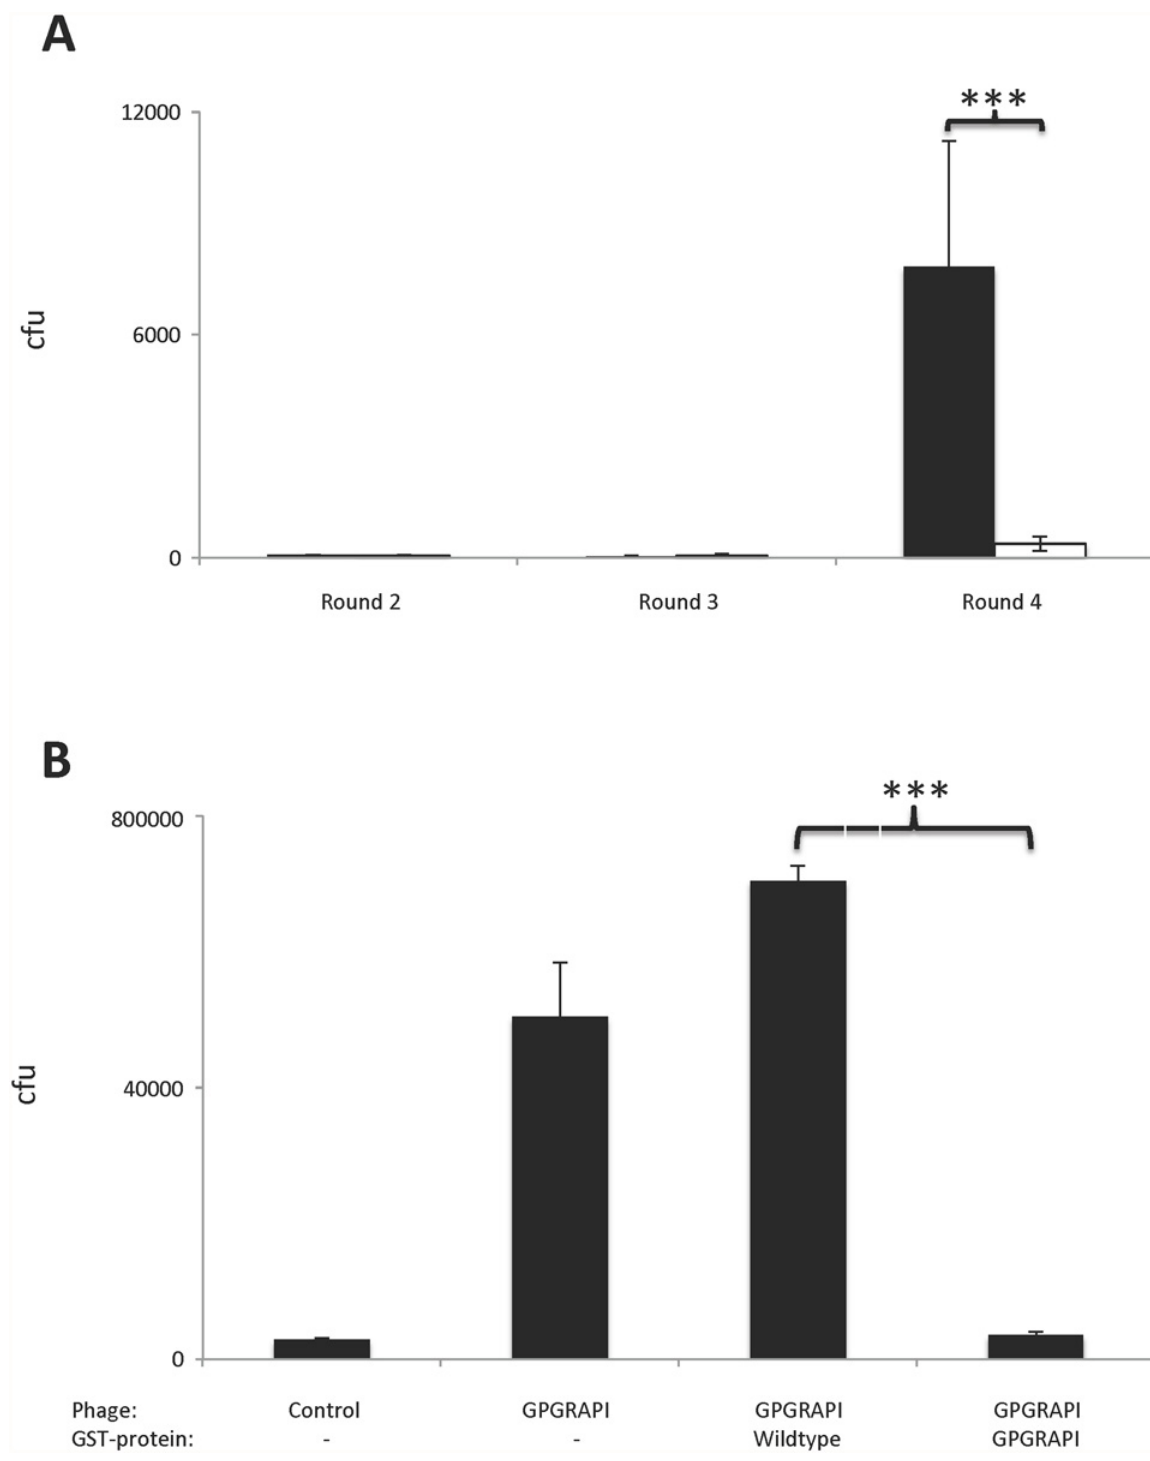
Fig 1. Screening of a random peptide phage display library on immobilized IgG from the index patient. A) Continuous enrichment of selected phage during the biopanning (Black column selected phage, white column control phage). B) Selected and enriched phage GPGRAPI bind specifically to immobilized IgG: Addition of GPGRAPI-GST but not wildtype-GST fusion protein competitively inhibits phage binding (p < 0.0001) to immobilized IgG of the index patient. Control phage bind lower than GPGRAPI phage. Error bars represent standard deviation of triplicates, *** indicates p < 0.0001. cfu = colony forming